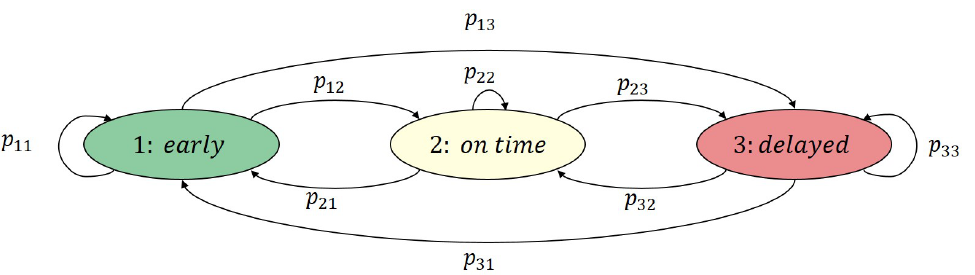
Figure 1. Visualization of a Markov chain for train delays with three states of